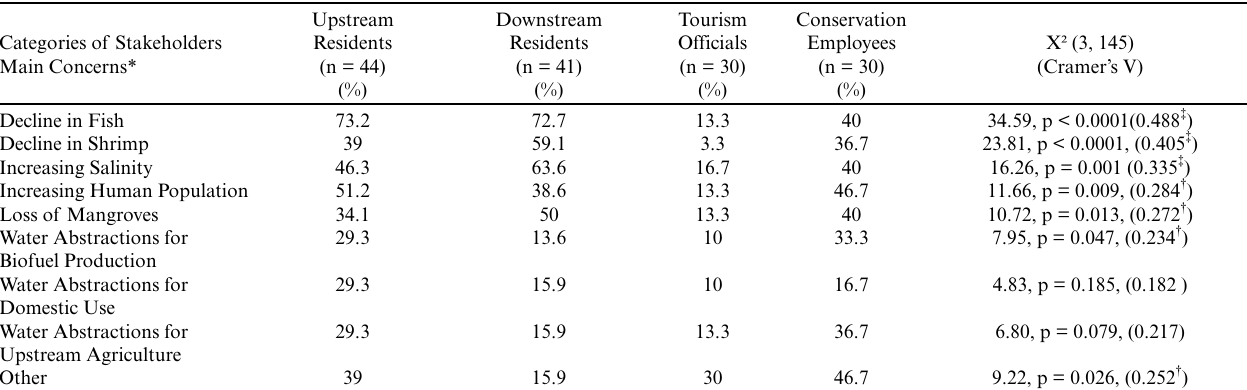
Table 4 . Main concerns of each stakeholder group regarding the future conditions of the Wami River and Estuary.